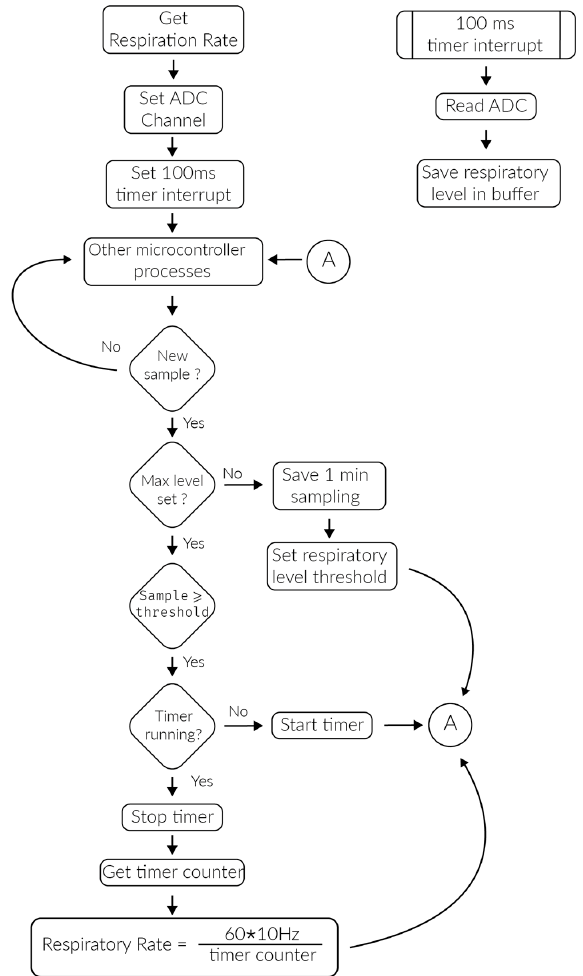
Figure 5. Respiration rate monitoring algorithm.